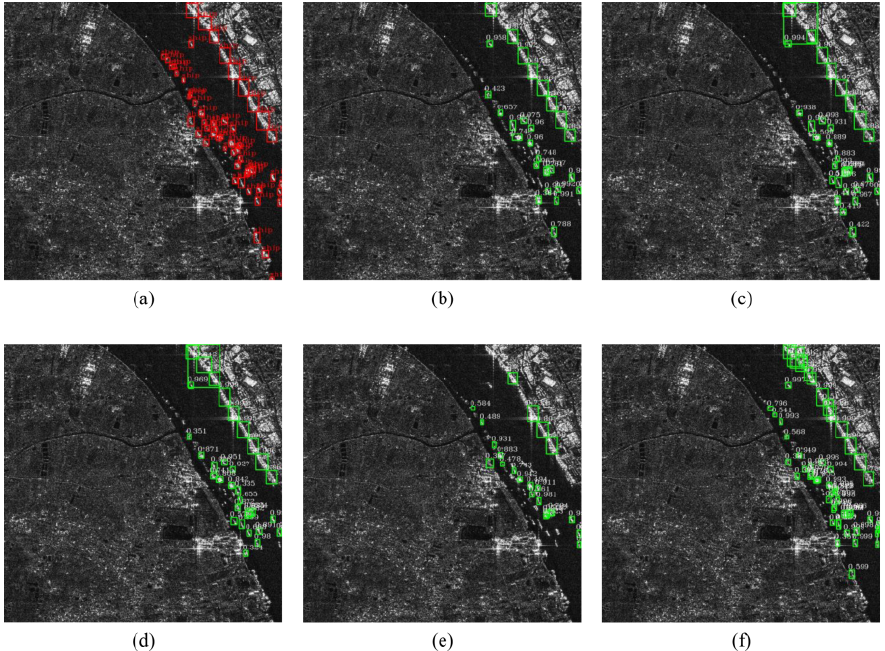
Figure 10. Comparison of detection results for different methods in the inshore scenes of the HRSID. ( a ) Ground-truth objects. ( b ) Detection results of the Faster R-CNN. ( c ) Detection results of the Double-Head R-CNN. ( d ) Detection results of the PANet. ( e ) Detection results of the RetinaNet. ( f ) Detection results of the ASAFE. Green bounding boxes denote the detection results. Red bounding boxes denote the ground-truth objects.